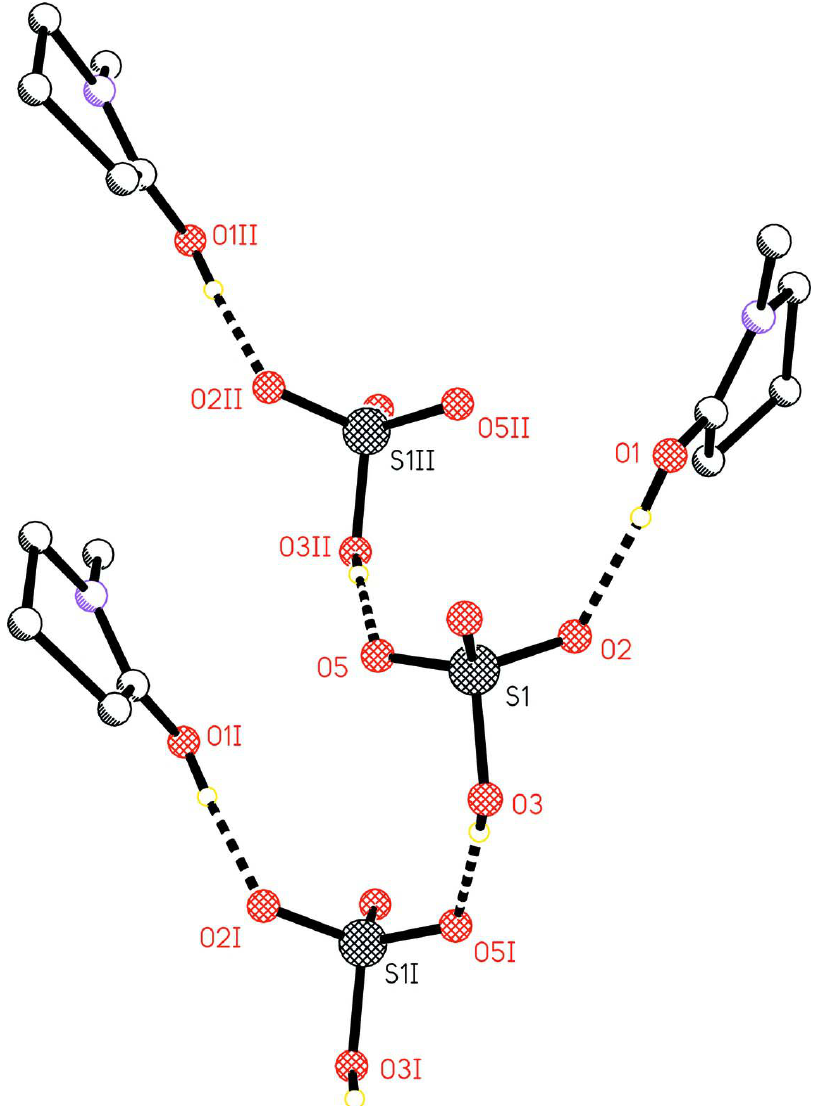
A view of the O—H···O hydrogen-bond pattern. The H atoms that are not involved in the O—H···O hydrogen bonds have been omitted for the sake of clarity. The chains of the hydrogensulfates are oriented parallel to the crystallographic axis a . Symmetry codes: (I) x - 1/2,0.5 - y ,- z ; (II) x + 1/2,0.5 - y ,- z